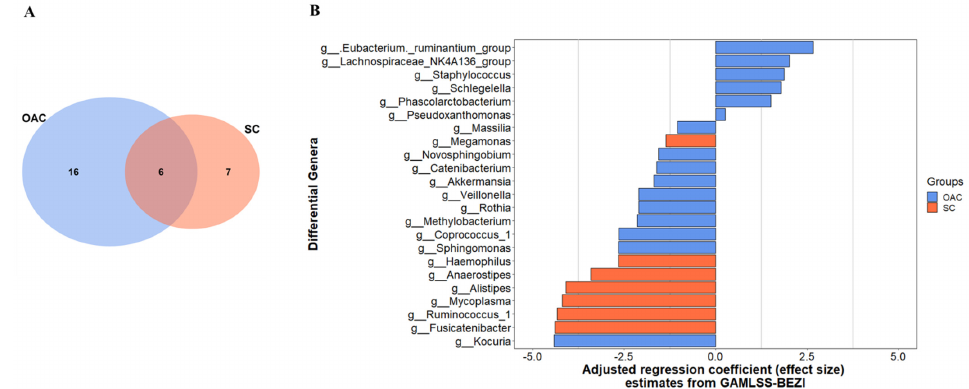
Figure 3. Differential genera between groups in the 7th day of life (T1) comparing to the first day of life (T0); shared and unique genera between groups ( A ), and the adjusted regression coefficient estimates from GAMLSS-BEZI ( B ). Legend: GAMLSS-BEZI (Generalized Additive Models for Location, Scale, and Shape with a zero inflated beta family); OAC (Oro- pharyngeal Administration of Colostrum); SC (Standard Care).